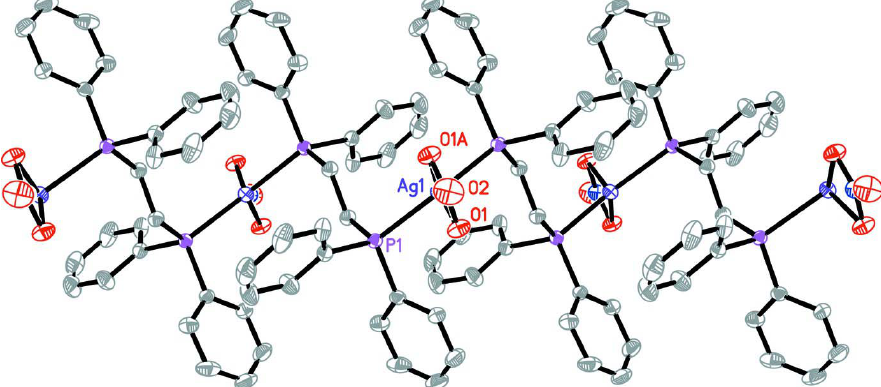
Figure 2 The coordination polymer of (I) [symmetry code: (A) -x, y, 1/2 - z] along the c axis. catena -Poly[[(nitrato- κ 2 O , O ′ )silver(I)]- µ -1,2-bis(diphenylphosphino)ethane- κ 2 P : P ′ ] Crystal